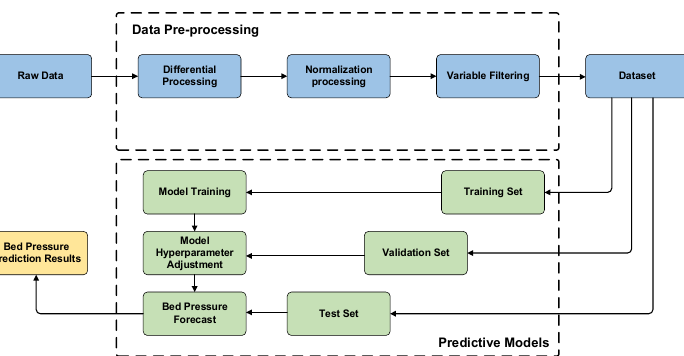
Figure 6. Prediction flow diagram. The data are sequentially differenced and normalized. The variables are filtered by training set and validation set. Finally, the parameters of the model are trained by the training set. The hyperparameters of the model are selected by the validation set.